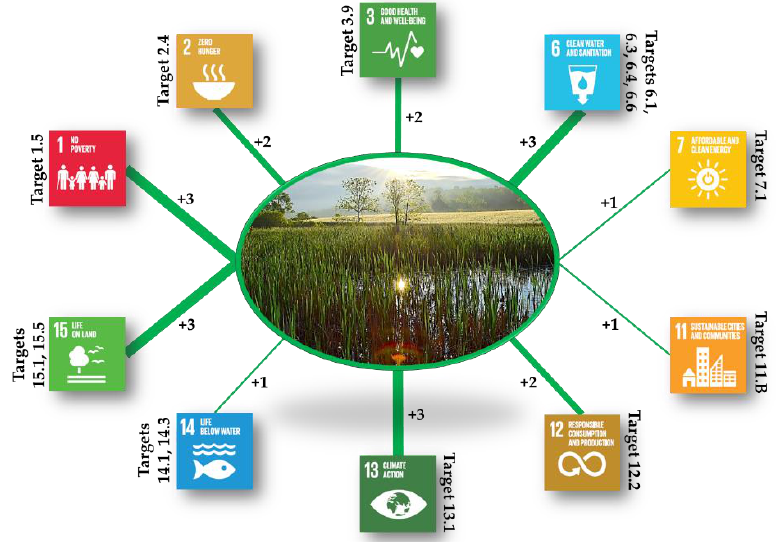
Figure 3. Positive water regulation interactions identified between United Nations Sustainable Development Goals (SDGs) and Swedish wetland ecosystem services. Photo: http://www.kimointernational.org/feature/swedish-municipalities-harness-ecosystem-services/.